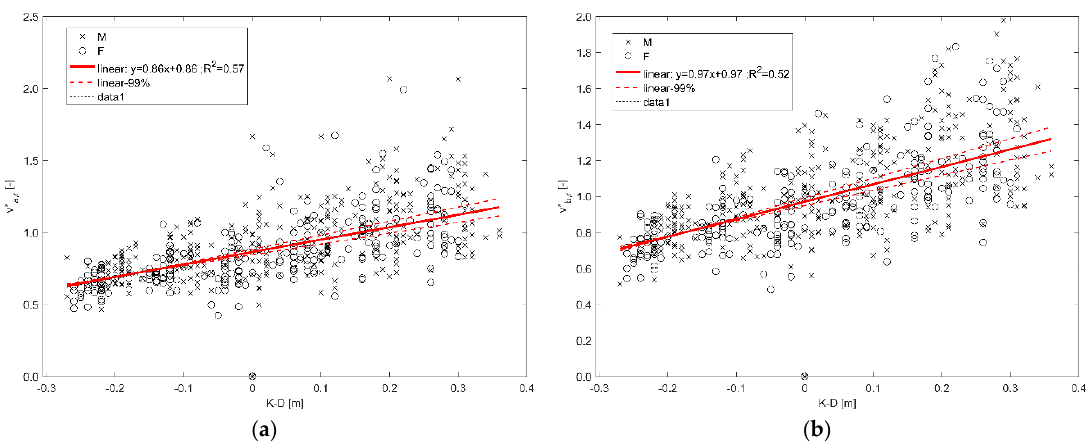
Figure 9. Normalized speed variation for running conditions depending on K-D in respect to dry surface motion conditions, for the whole sample (male and female together): ( a ) according to the curve a [46]; ( b ) according to the curve b [43]. Linear regressions (dashed lines refer to expected values outside of the tested D range) and boundary conditions (99%) are shown. Male and female samples experimental pairs are shown.